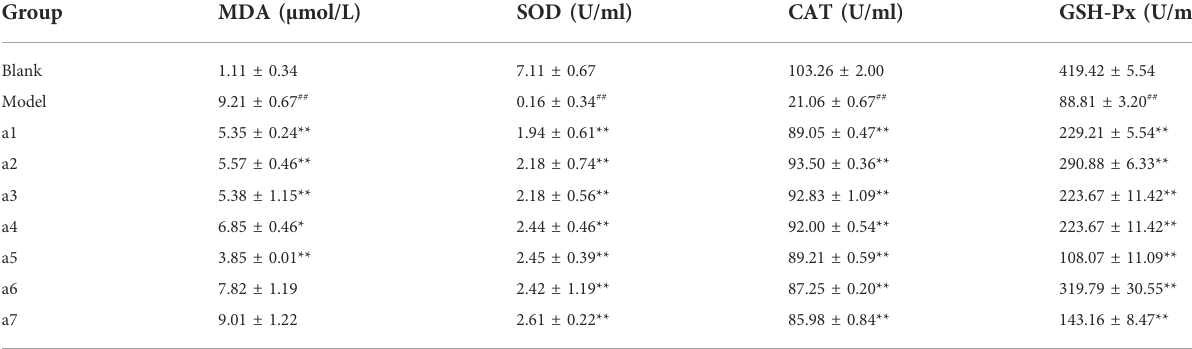
TABLE 2 Effect of 7 key active ingredients on the changes of MDA and antioxidant enzyme activity in PC12 cells induced by LPS. Group MDA ( μ mol/L) SOD